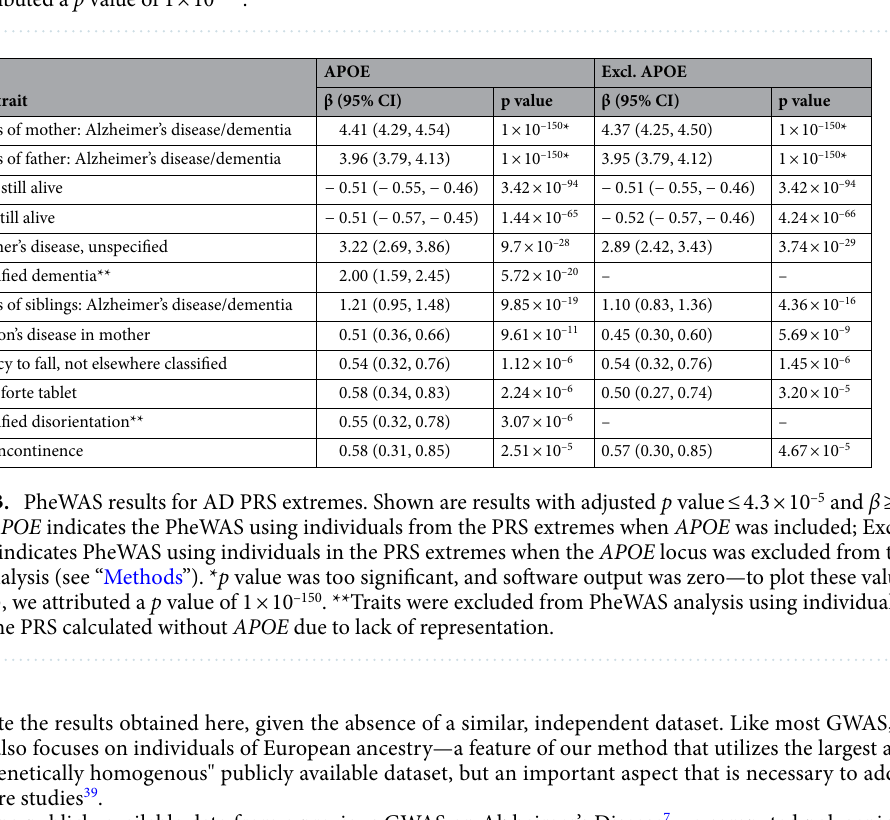
Figure 6. Phenome Scan results. The analysis was made with individuals in each extreme of the PRS distribution (including and excluding the APOE locus) using PHESANT. Each color represents a group of traits/ diseases, according to the UKBB hierarchical tree. Downward triangles represent results from individuals in the extremes of the PRS calculated when excluding APOE (no APOE). The size of triangles represents the beta value for the association. Vertical dashed lines connect results for the same trait in the APOE and no APOE analyses. Y-axis is the logarithmic scale for the p value, multiplied by the beta value, to depict whether the trait is negatively or positively associated. Red dashed lines represent the adjusted Bonferroni p value threshold. *Note: "Illnesses of father/mother: Alzheimer’s Disease/Dementia" had a software output p value of 0, to represent these we attributed a p value of 1 × 10 –150 .